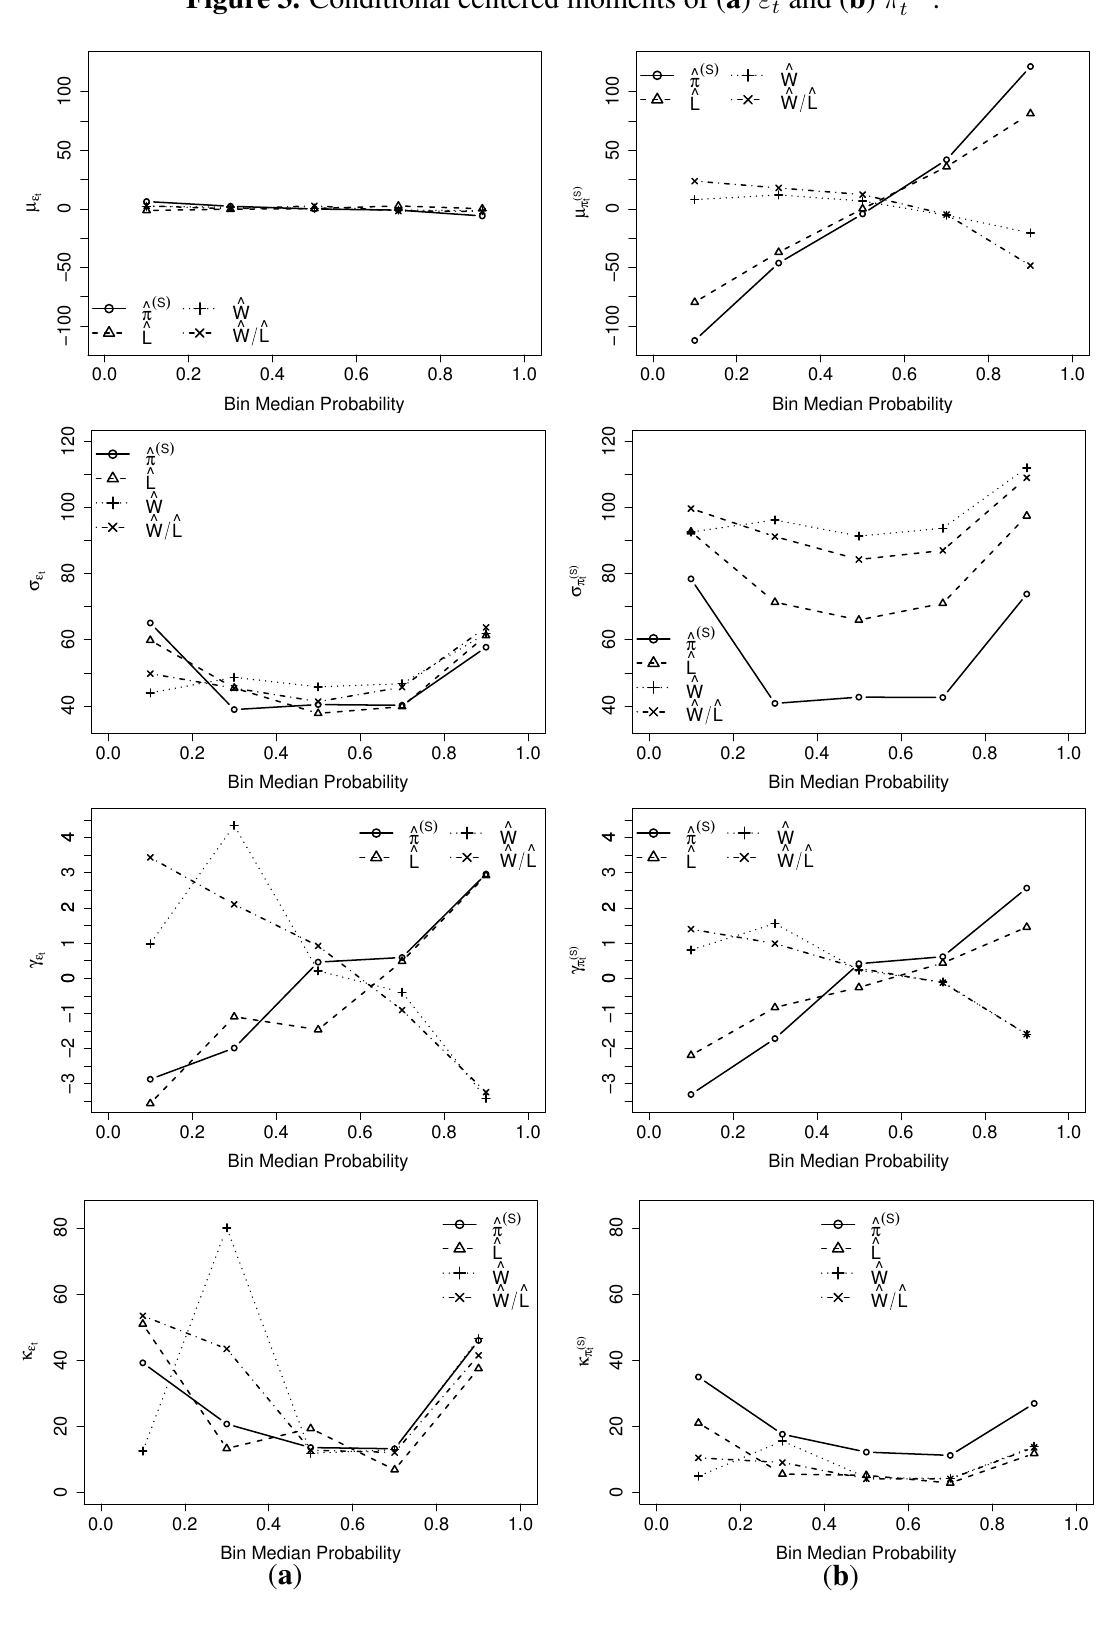
Figure 3. Conditional centered moments of ( a ) ε